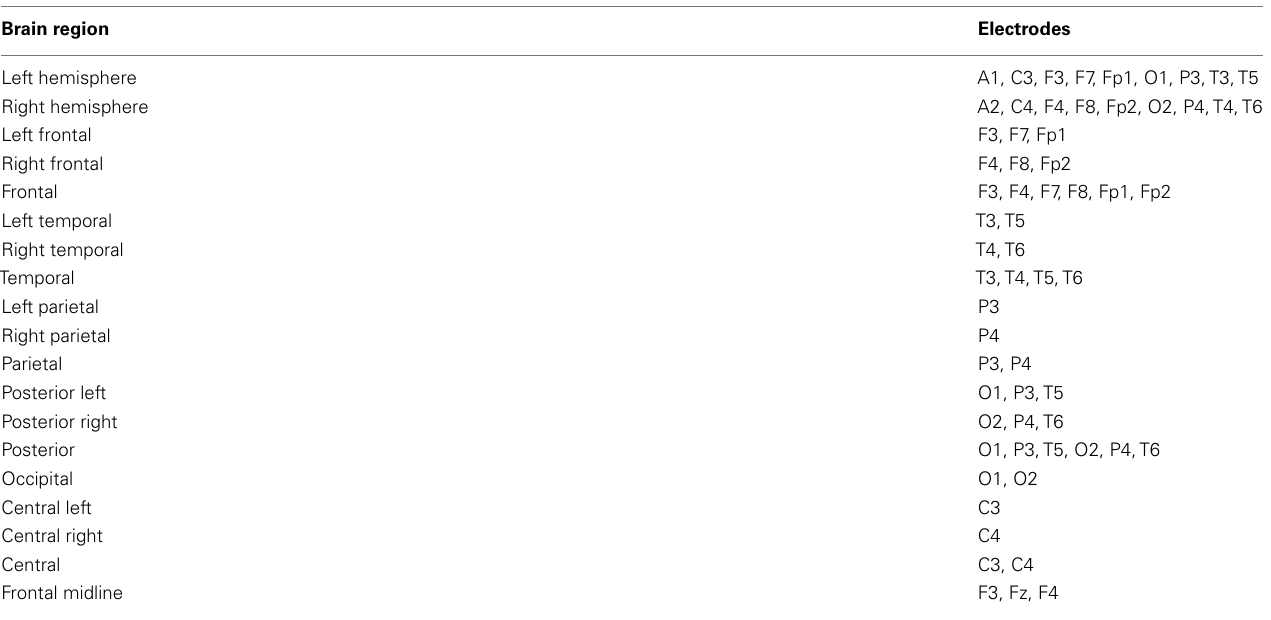
TableA1 | Brain regions and pooled